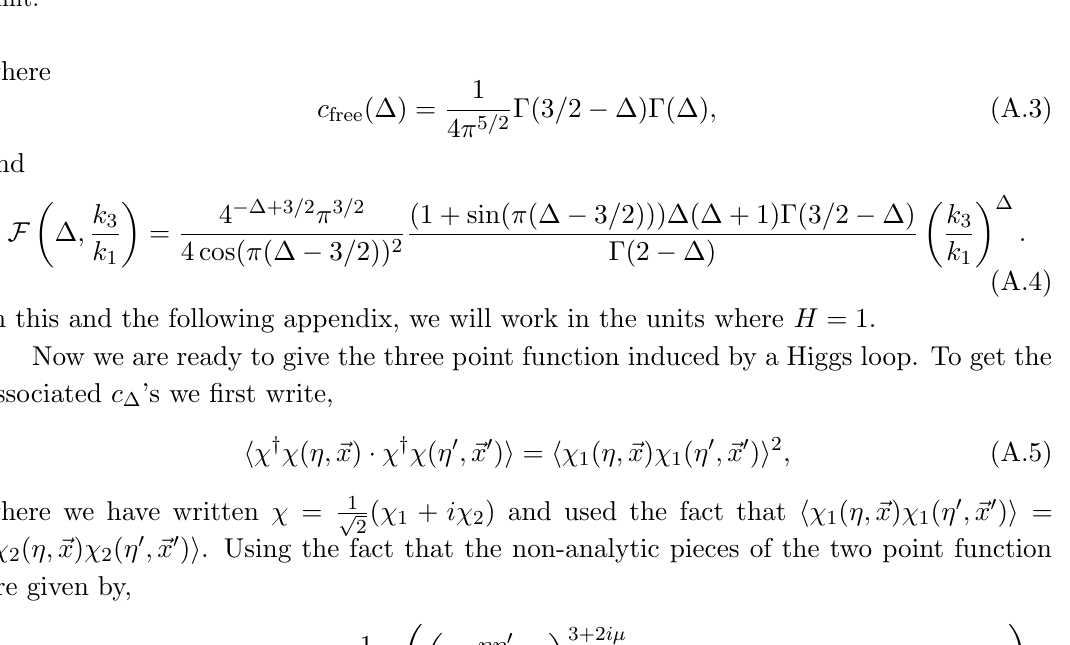
Figure 7 . Reduction of a loop diagram into a linear combination of tree diagrams in the squeezed